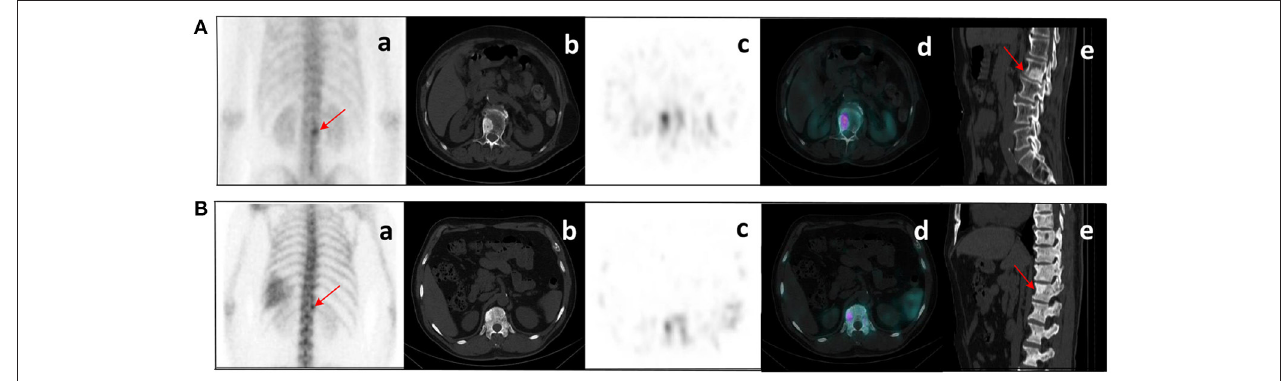
FIGURE 7 | (A) bone metastases: a 76-year-old male with prostate cancer. Nodular high-density shadow on the right lower edge of the L2 vertebral body with a concentrated radioactive tracer (arrows). (B) benign bone lesions: a 60-year-old male with prostate cancer. Nodular high-density shadow on the right upper edge of the T12 vertebral body with increased radioactive tracer distribution (arrows). The cluster of radioactive tracer concentrations in the left rib(a), with fusion images suggesting bone metastasis. Lesion (A) showed increased concentration of tracer and increased extent of concentration with systemic bone metastases at subsequent imaging follow-up. Lesion (B) was confirmed not a metastasis from prostate cancer at several subsequent imaging follow-ups.